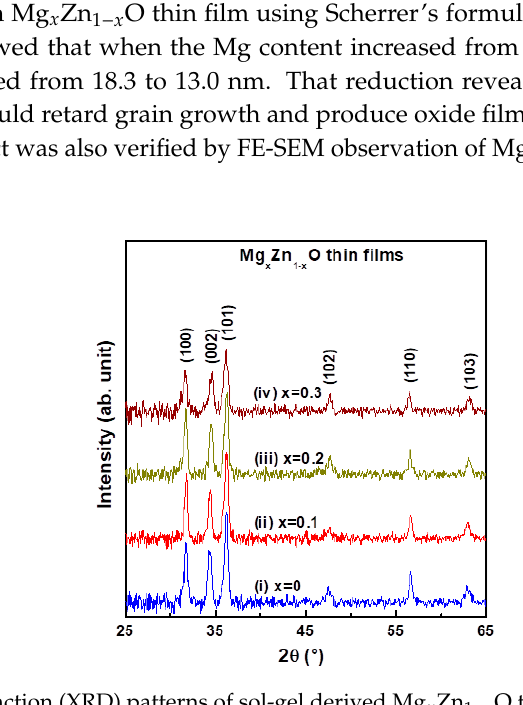
Figure 2. X-ray diffraction (XRD) patterns of sol-gel derived Mg x Zn 1 − x O thin films with different Mg Figure 2. X-ray di ff raction (XRD) patterns of sol-gel derived Mg x Zn 1 − x O thin films with di ff erent Mg contents on glass substrates. contents on glass substrates. Table 1. Structural features and optical properties of sol-gel derived Mg x Zn 1 − x O thin